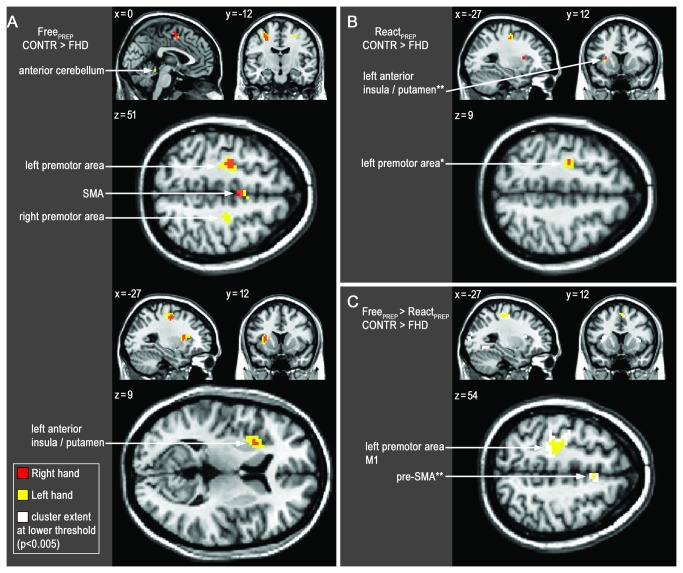
Between-group Activation Changes during Preparation of Movements.Decreased activity in patients (FHD) compared to controls (CONTR) during motor preparation (PREP). p<.001 (uncorrected), extent threshold 10 voxel. Right hand (red), left hand (yellow). A: Self-initiated B: Externally cued C: Reduced self-initiation-related activity (white: p<0.005). Note effector independent distributions. Coordinates shown (x, y, z) are in MNI-space.